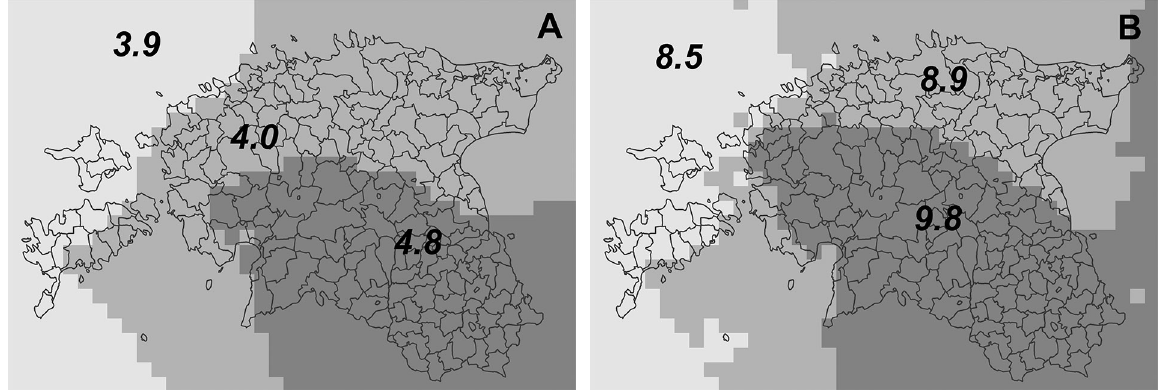
Fig. 3. Spring (MAM) air temperature (°C) regions and their average air temperature during the reference period 1971–2000 ( A ) and according to RCP8.5 for the period 2071–2100 ( B ).